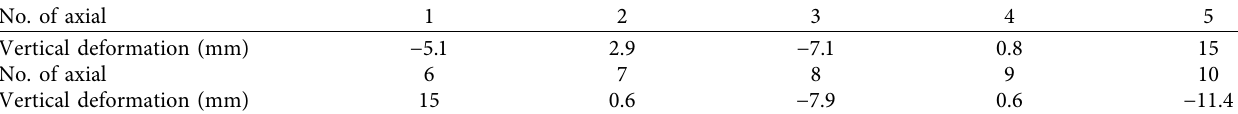
Table 4: Vertical deformation of midspan node of cable truss of secondary bearing